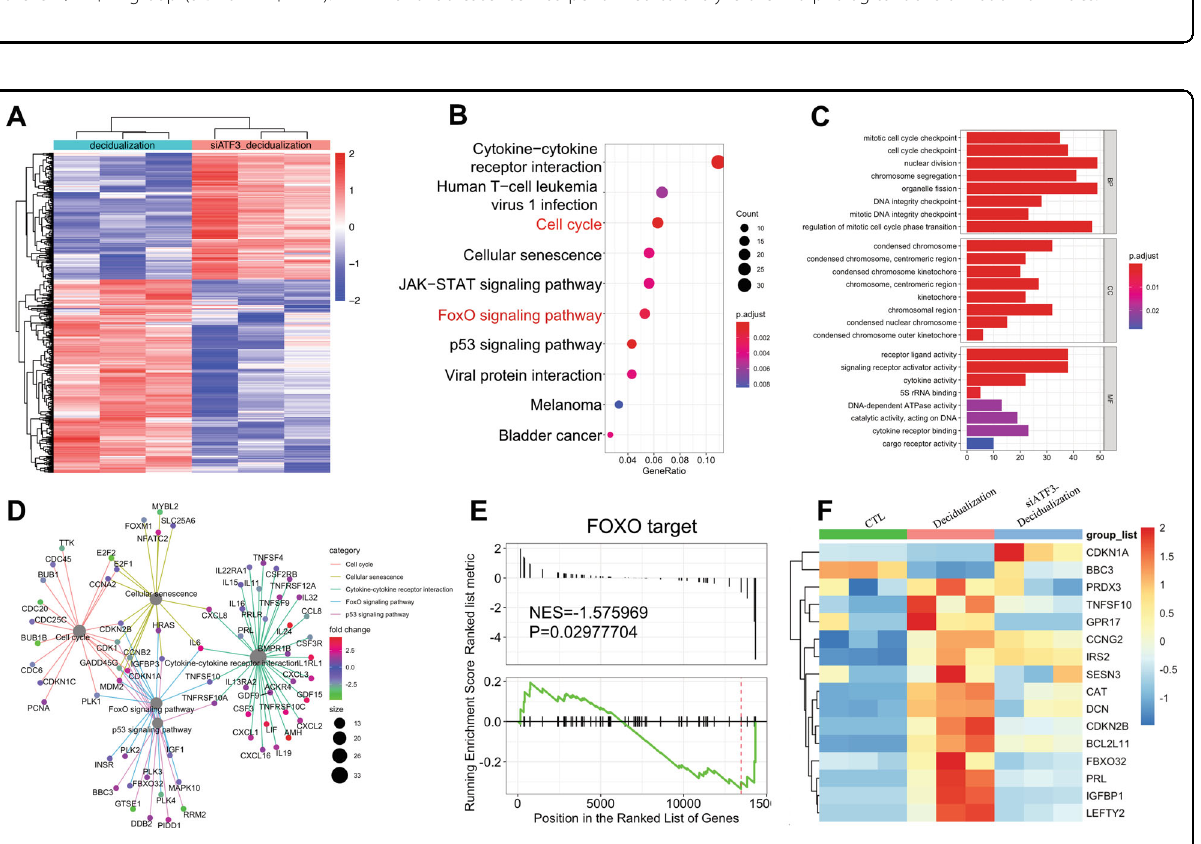
Fig. 3 DEGs in hESCs after knockdown of ATF3 during in vitro decidualization. A Heat map showing hierarchical clustering of gene expression in decidualization and knockdown of the ATF3 group. B , C KEGG pathway enrichment analysis and GO analysis of the DEGs. D The DEGs related to the altered KEGG pathways. E GSEA results showed that the FoxO-targeted gene term was downregulated when ATF3 was silenced. F The relative expression of FoxO1 target genes, such as PRL, IGFBP-1, DCN, and